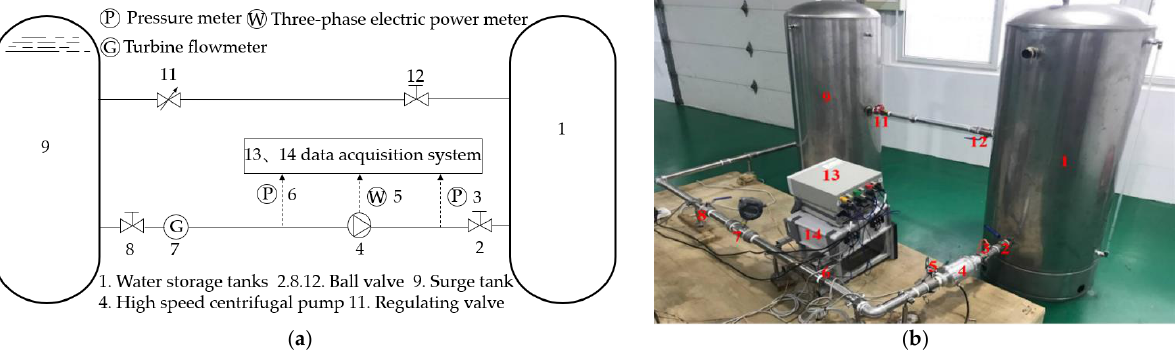
Figure 4. Comparison between numerical simulation results and experimental data. ( a ) Graph of system; ( b ) image of system. Table 2. Experimental uncertainty.